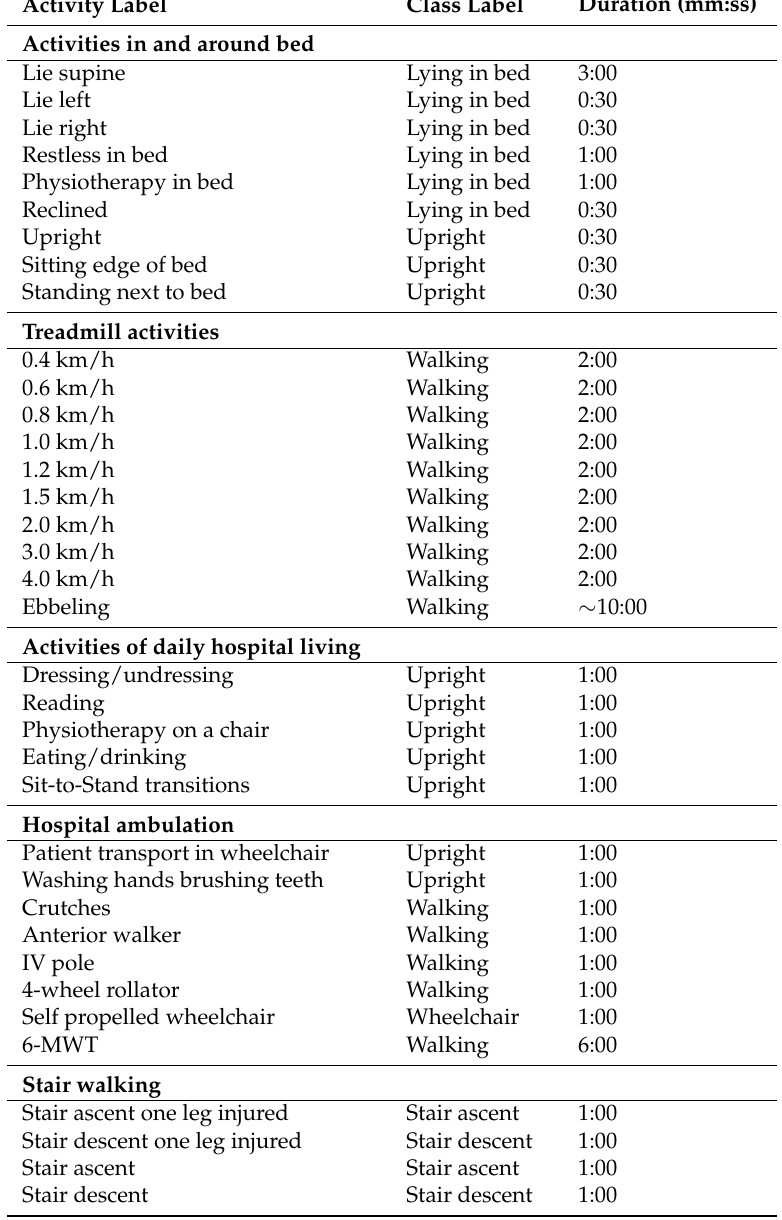
Table 1. Activities used in the study protocol, with corresponding class labels and duration per participant. 6-MWT stands for 6-minute walk